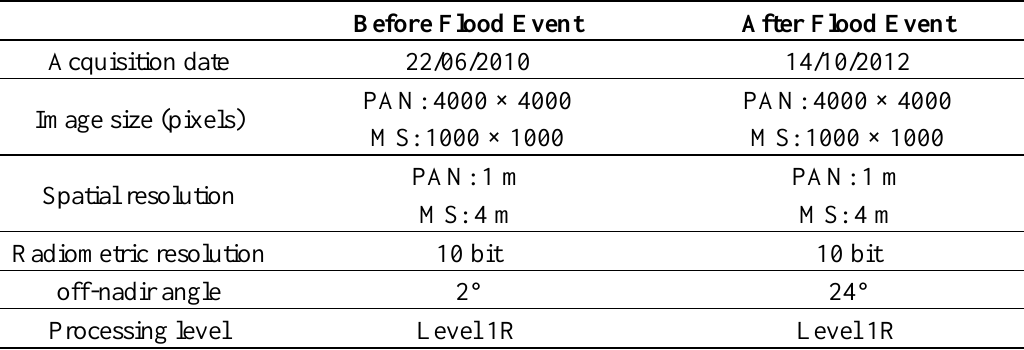
Figure 1. The fused images using GSA image fusion method: ( a ) the F 1 GSA-fused image generated from the KOMPSAT-2 satellite images collected before the flood event and ( b ) the F 2 GSA-fused image generated from the KOMPSAT-2 satellite images collected after the flood event. Table 1. KOMPSAT-2 satellite data